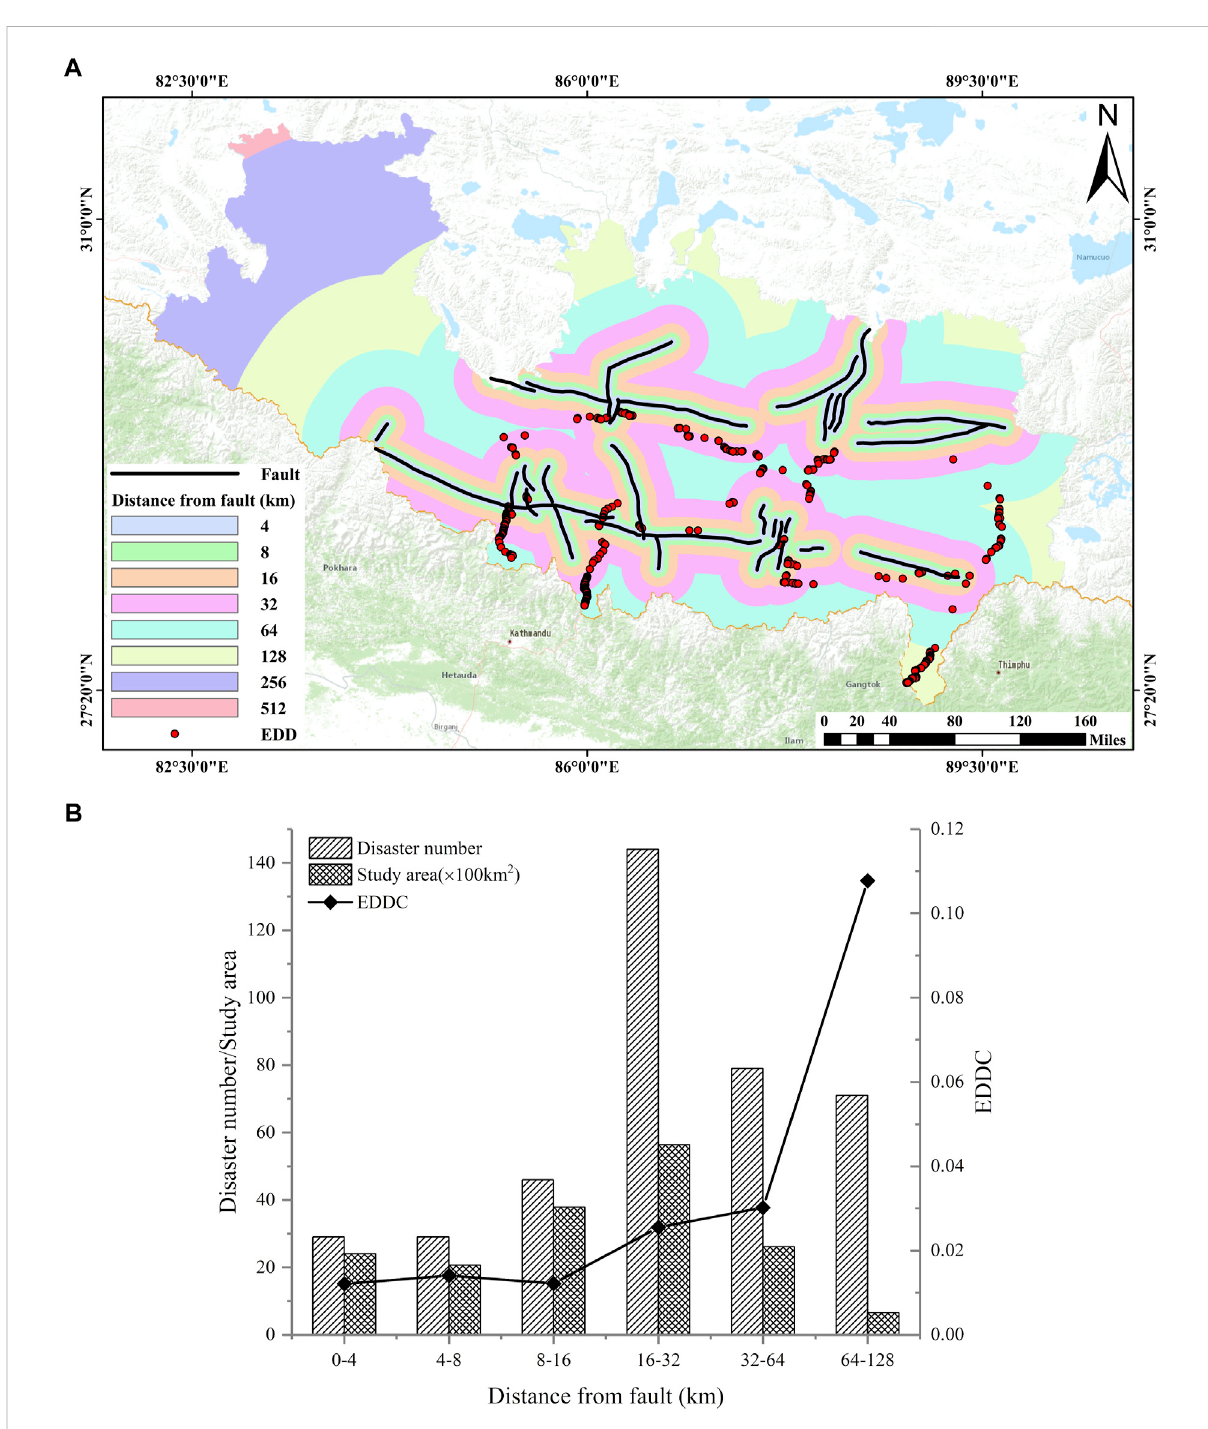
FIGURE 9 (A) Distance from fault map of the study area; (B) Relationship between engineering disturbance disaster distribution and distance from